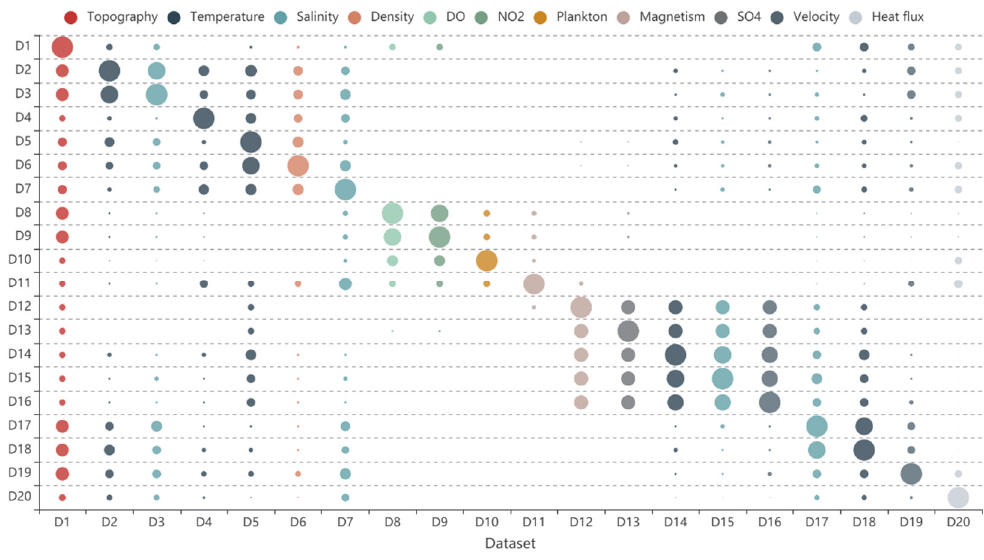
Figure 8. Data similarities of datasets.